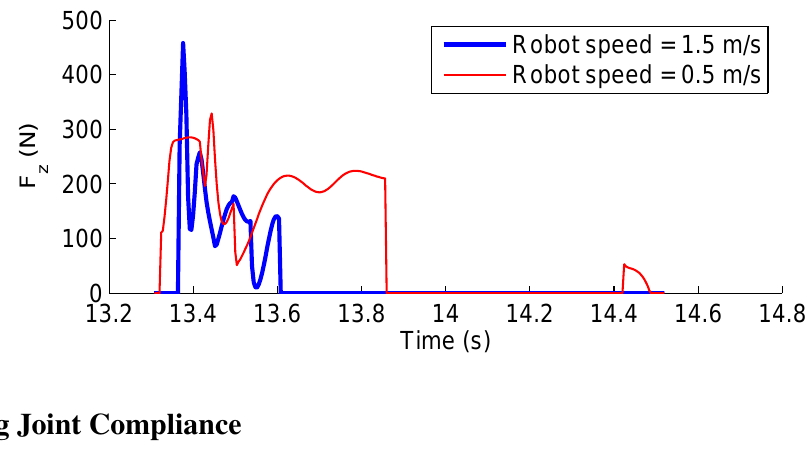
Figure 17. Ground reaction forces for the leg walking at 1.5 m/s (biomimetic design) and walking at 0.5 m/s for the real leg